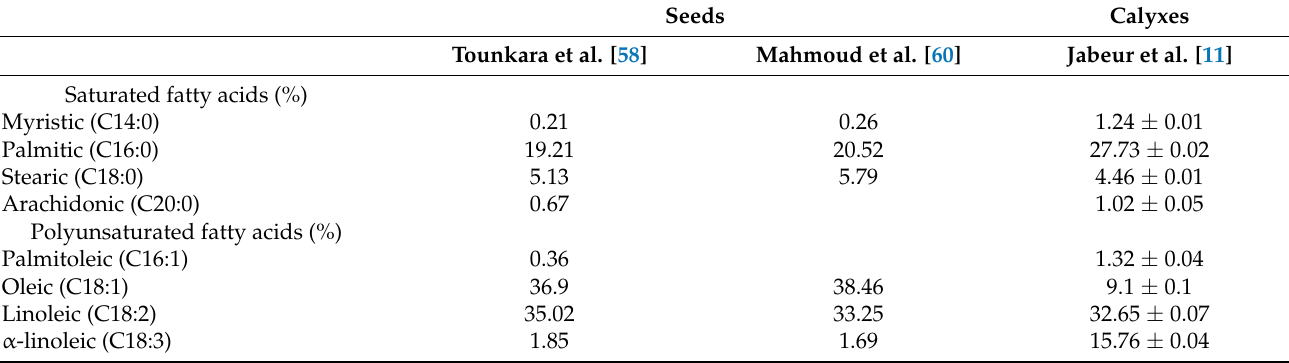
Table 2. Proportion of fatty acids in Hibiscus sabdariffa L. seeds and calyxes. Seeds Calyxes Tounkara et al. [58] Mahmoud et al. [60] Jabeur et al.